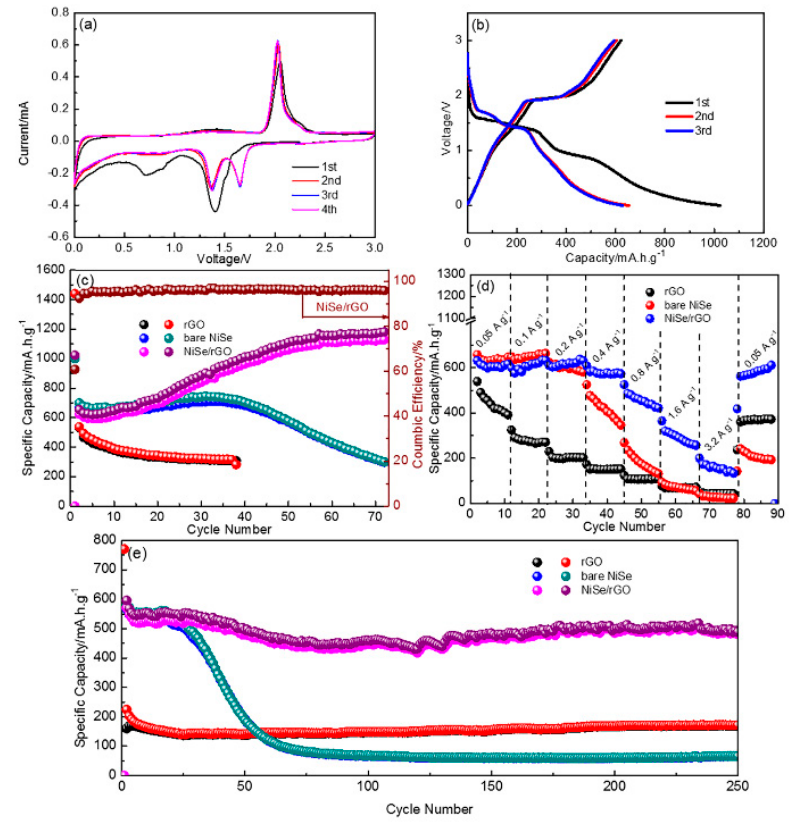
Figure 6. Electrochemical lithium storage performances of as-prepared electrodes. ( a ) cyclic voltammetry (CV) curves of NiSe / rGO at a scanning rate of 0.1 mV s − 1 ; ( b ) the profiles of initial three cycles of NiSe / rGO at 0.05 A g − 1 ; ( c ) cycling performance; ( d ) rate performance; and ( e ) long-term cycling performance of NiSe / rGO composite, bare NiSe, and rGO electrodes.